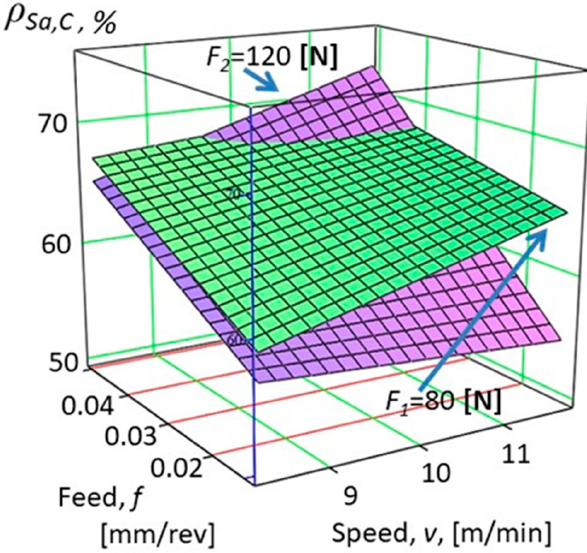
Figure 13. Improvement of the change of surface roughness ρ Sa , C on specimens marked C (see Equation (11)).